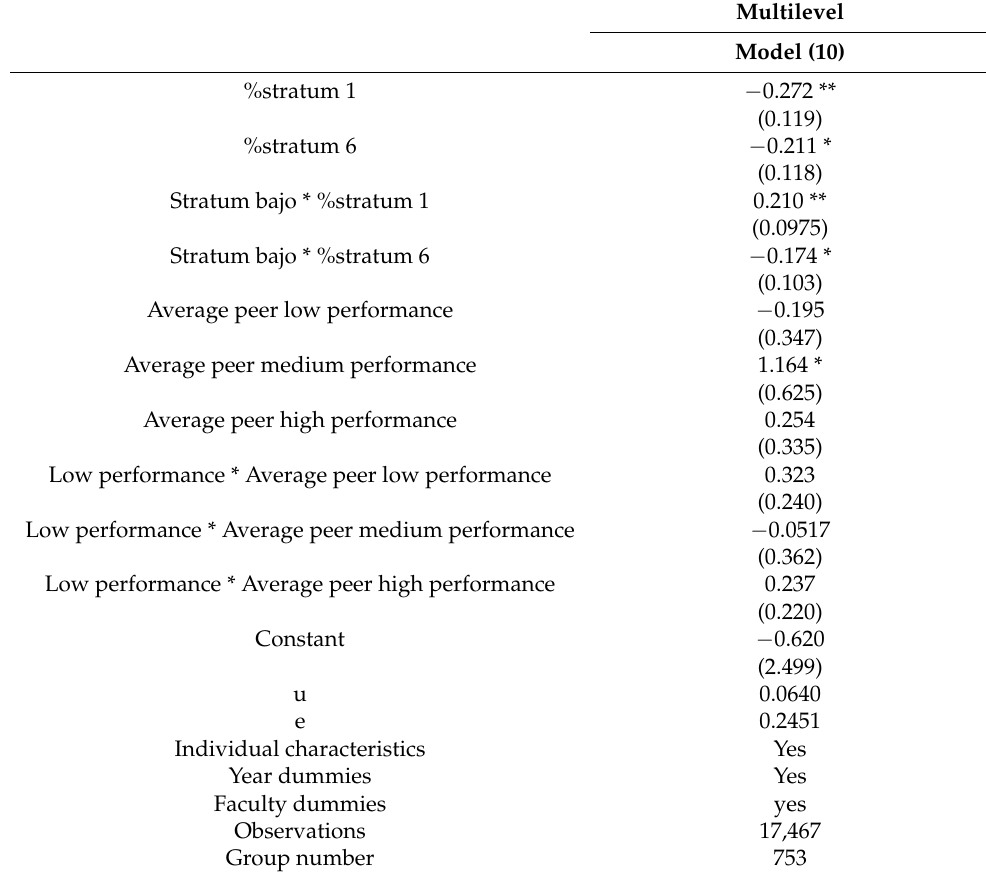
Table A9. Effects of heterogeneous peers according to students’ socioeconomic level in Communica- tion Skills